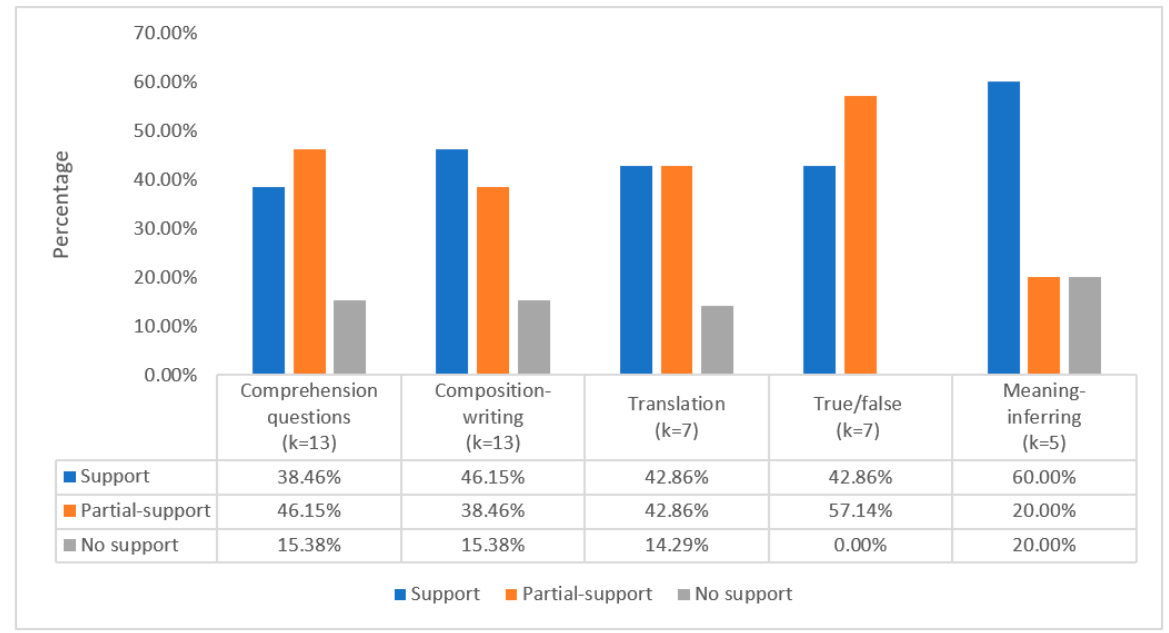
Figure 11. Medium-frequency task types and ILH support in studies.